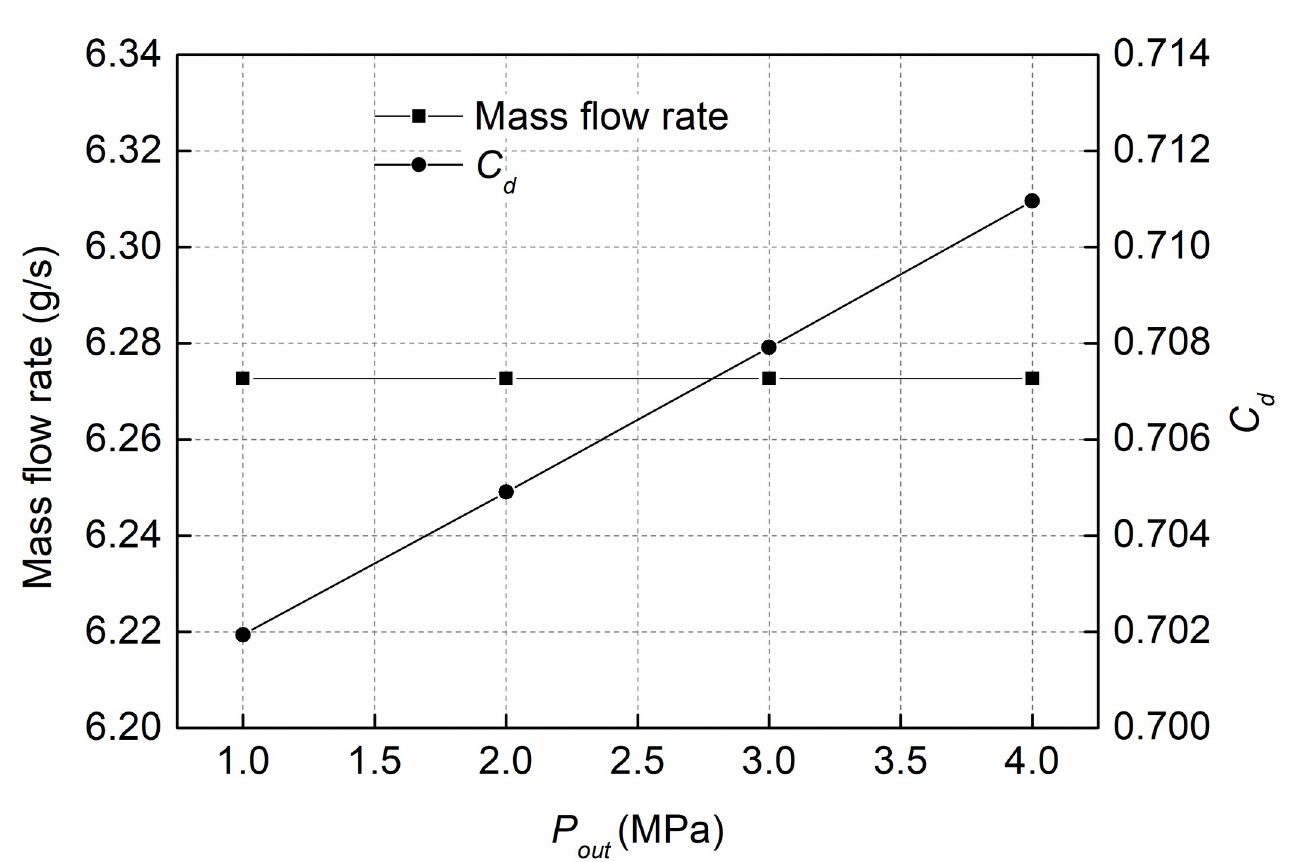
Fig 11. Mass flow rate and discharge coefficient at various P out and fixed P in of 120MPa.